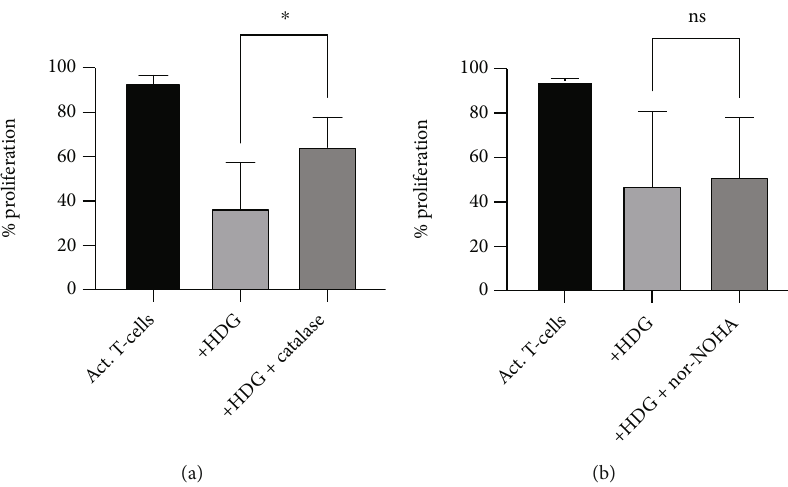
Figure 4: Catalase partially recovers the proliferation of T-cells. (a) Addition of the ROS inhibitor catalase to the coculture reverted the inhibitory e ff ect of healthy blood NDG ( n = 6 ), and T-cell proliferation was partially recovered ( p = 0 : 0312 ). (b) When adding the arginase inhibitor nor-NOHA, the proliferation of T-cells was not recovered ( p = 0 : 780 ) ( n = 10 ).